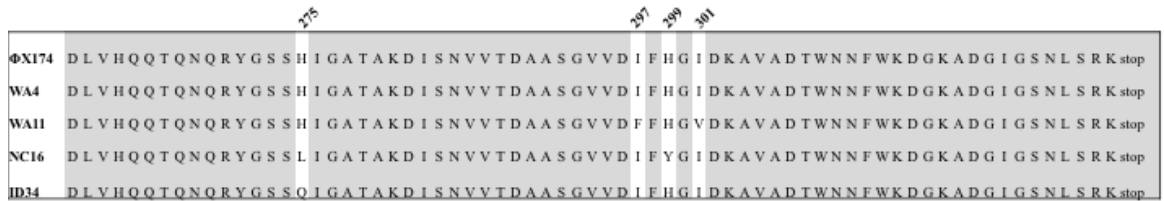
Figure 5. Alignment of amino acid sequences of the reduction sequence portion of Φ X174 and Φ X174-like wild phages protein H sites 259–329. Differences occur at amino acids 275, 297, 299, and 301 and are